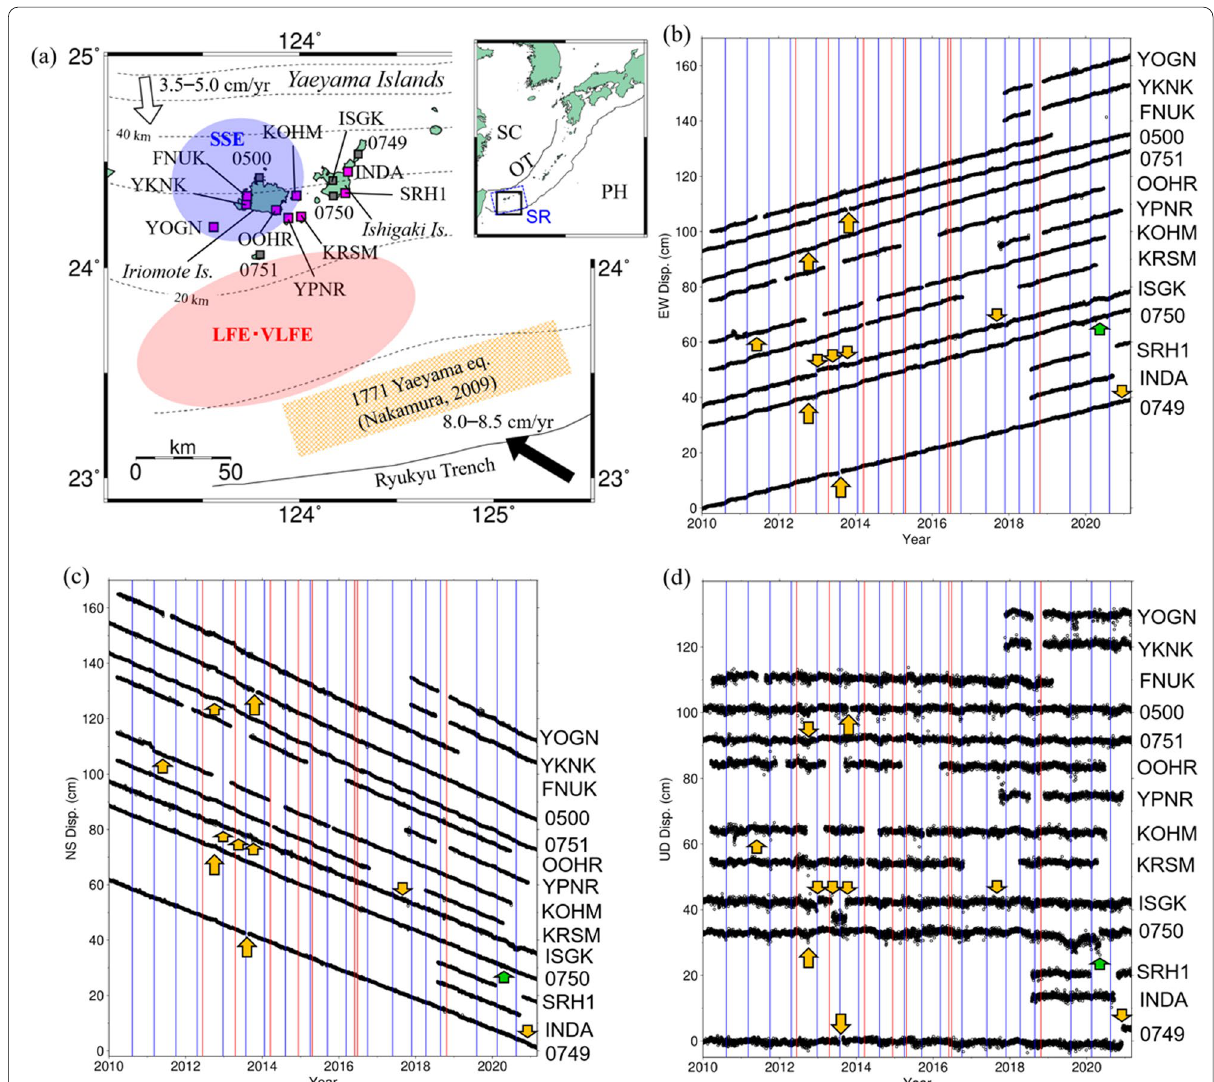
Fig. 1 Tectonic setting and GNSS time series. a Study area. The black rectangle in the inset is the location of the Yaeyama Islands where the Philippine Sea plate (PH) is subducting beneath the islands at a rate of 8.0–8.5 cm/year relative to the South China block (SC) (Sella et al. 2002). The Yaeyama Islands are considered to be located on the South Ryukyu block (SR), which are roughly indicated by the dotted blue rectangle (Nishimura et al. 2004). The squares are the locations of the GNSS stations with four-digit station codes. The purple squares indicate the stations newly installed after 2010. The red-, blue-, and orange-colored regions correspond to the source areas of slow slip events (SSEs) (Heki and Kataoka 2008), low-frequency earthquakes (LFEs) (Arai et al. 2016; Nakamura 2017), and the estimated source area of the 1771 Yaeyama earthquake (Nakamura 2009). The white arrow represents the motion of the back-arc spreading of the Okinawa Trough (OT) (Nishimura et al. 2004). The location of OT is indicated in the inset. The solid and dashed lines are the Ryukyu Trench and the depth contours of the upper surface of the subducting PH with an interval of 10 km (Slab 2) (Hayes et al. 2018). b – d GNSS time series sorted from westernmost (top) to easternmost (bottom) stations in b east–west, c north–south, and d up–down components. The red and blue vertical lines represent the timings of earthquakes considered in this study and the occurrence of SSEs. The timings of SSEs were determined by Tu and Heki (2017) before 2016 and by visual inspection after 2017. The orange arrows indicate the timings of antenna replacements, and green arrows indicate an unknown offset appearing in the up–down component, which was eliminated in estimating velocities. GNSS Global Navigation Satellite